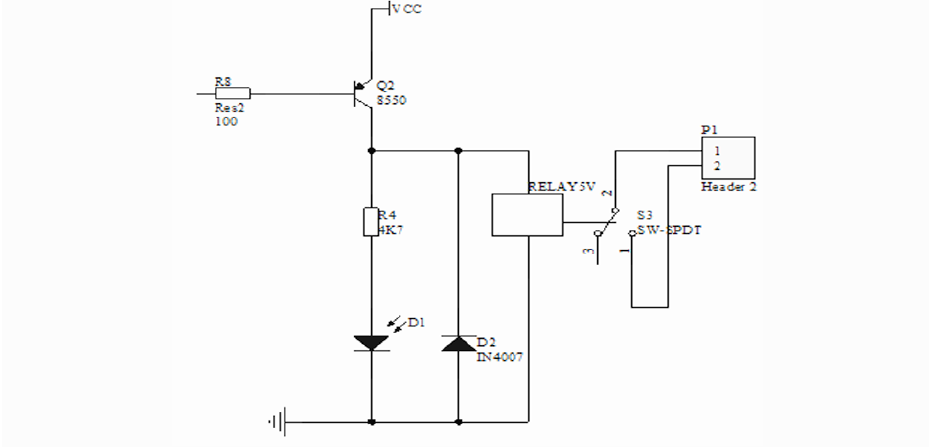
Figure 4. Temperature and humidity control